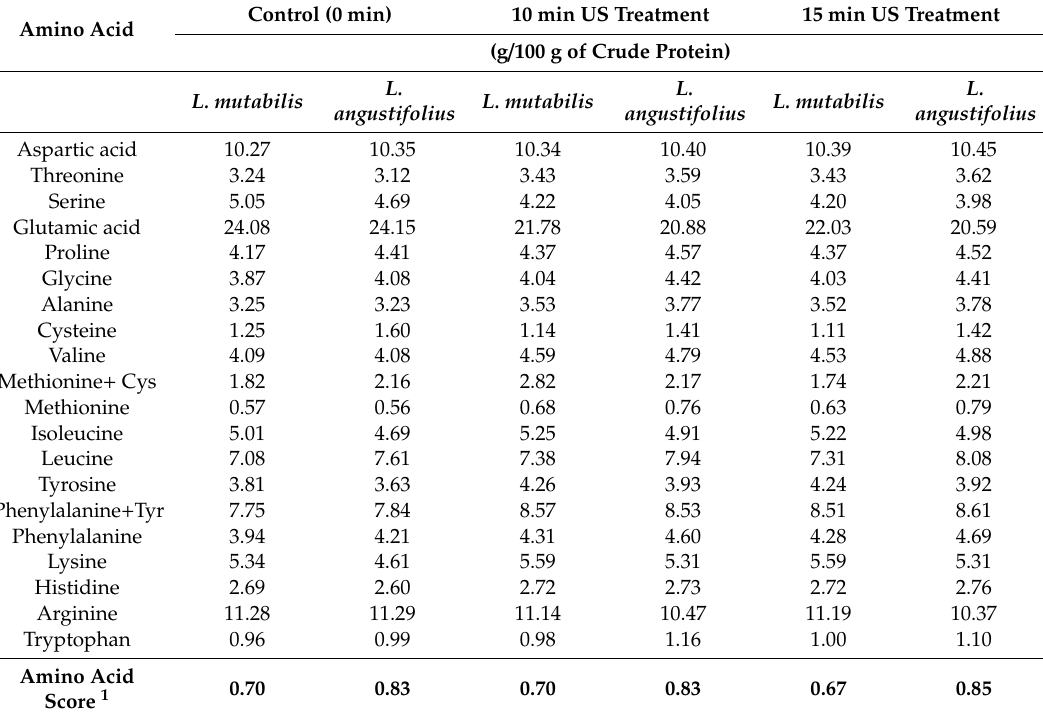
Table 5. Amino acid profile of L. mutabilis and L. angustifolius protein isolates obtained with the di ff erent US-assisted alkaline extraction.